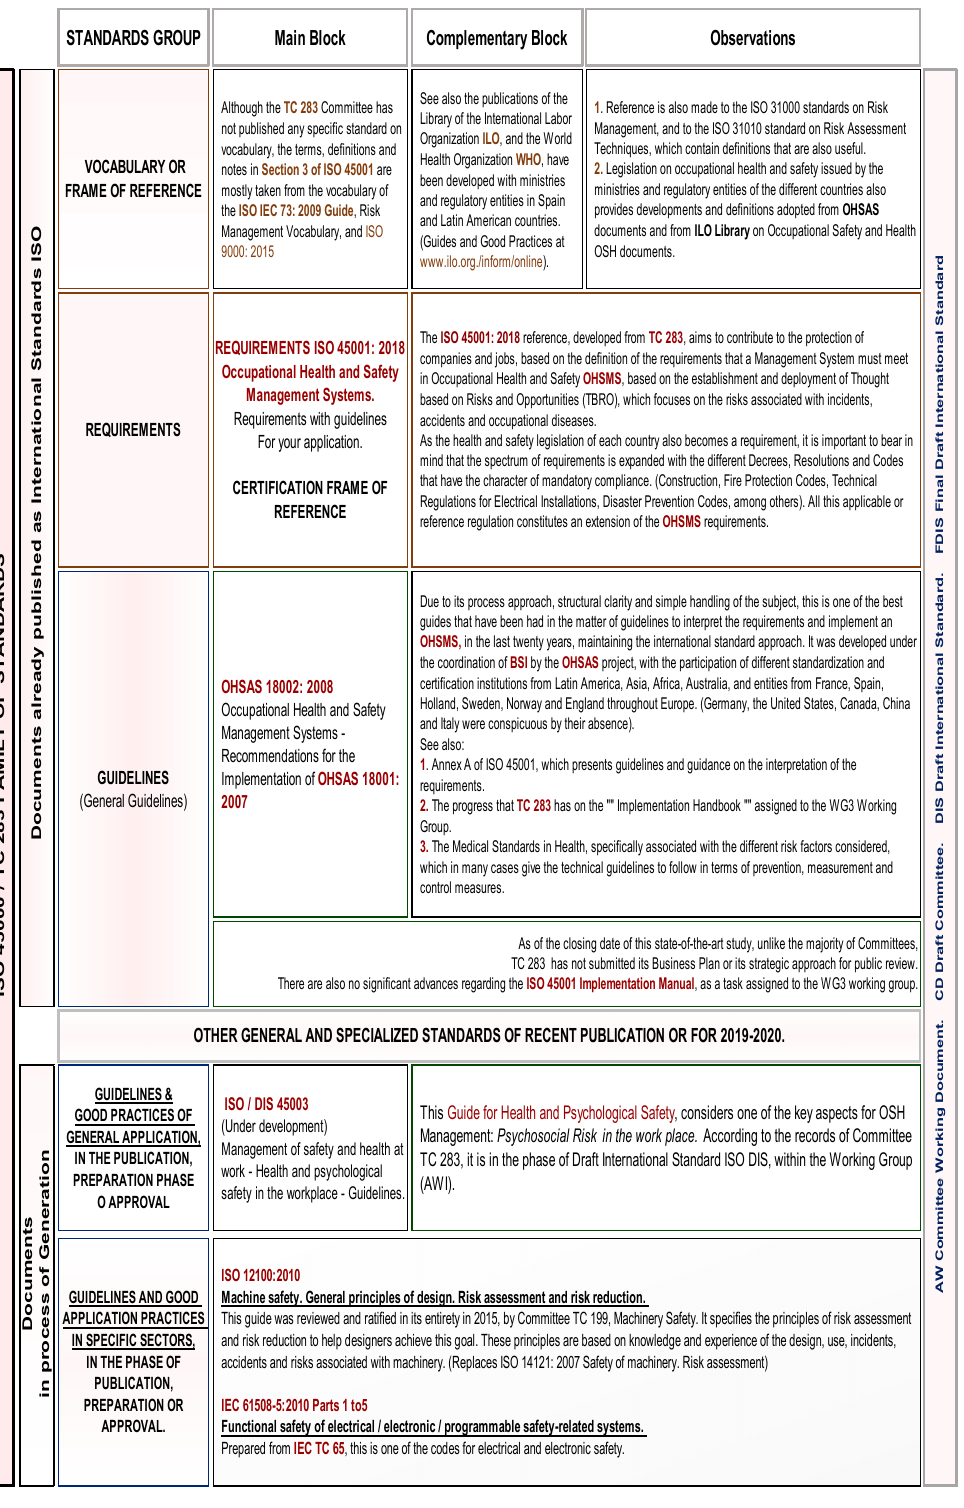
Figure A3. Approach and Logical Structure of the ISO 45000 Family of Standards [26,60,64].